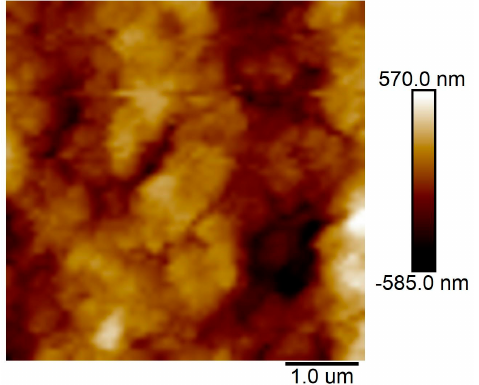
Figure 5. An AFM image of an MSQ aerogel coating layer on ePTFE thin film with 16.5 wt.% Si-Ti sol.